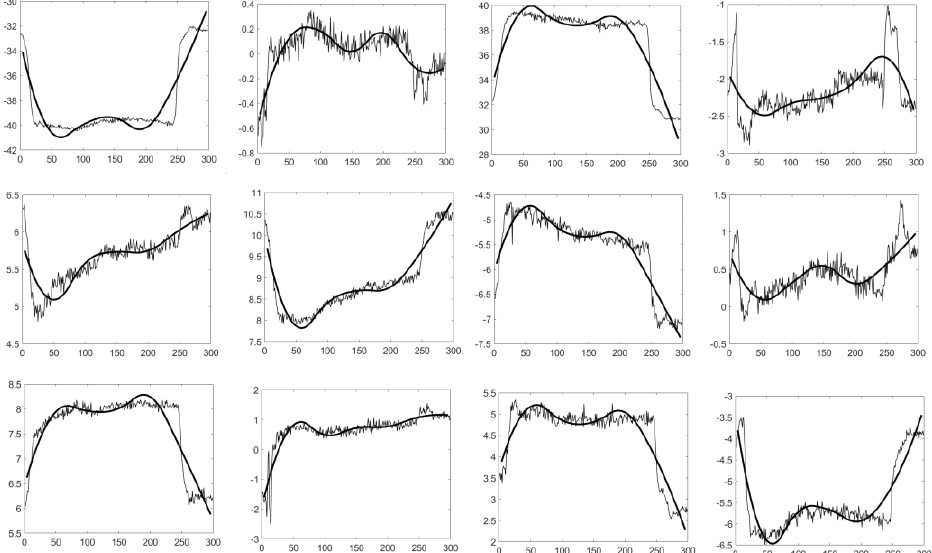
Figure A3. Examples cubic spline fits (thicker lines) to the real data (thinner lines) for the Smile dataset. From to left to right: first column, 𝑦 -positions of the 1st point (left corner of the mouth); second column, 4th point (middle upper boundary); third column, 7th point (right corner of the mouth); and fourth column, 10th point (middle lower boundary). Upper row includes the 𝑥 -components, middle row includes the 𝑦 -components, and bottom row includes the 𝑦 -components. The smile is evidenced (e.g.,) by the corners of the mouth for the 1st and 7th points being drawn outwards ( 𝑥 -components increase in magnitude) and backwards ( 𝑧 -components increase in magnitude).